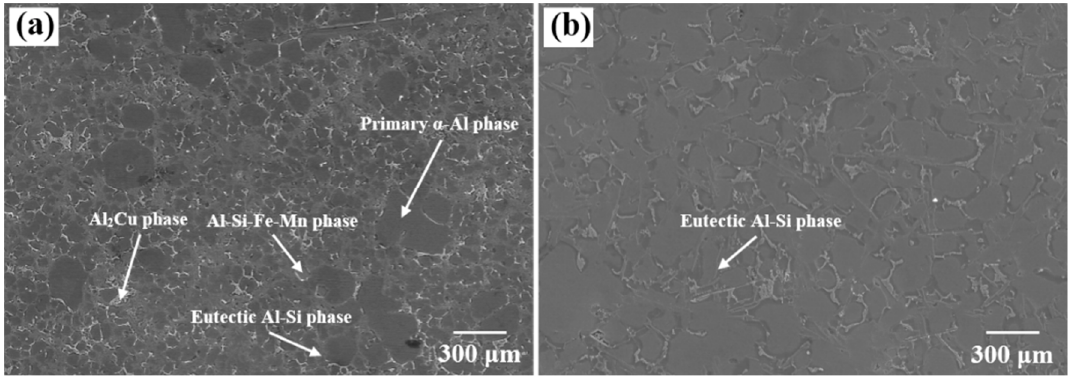
Figure 4. Microstructure of different areas of the casting: ( a ) thin-walled area, ( b ) thick-walled area.